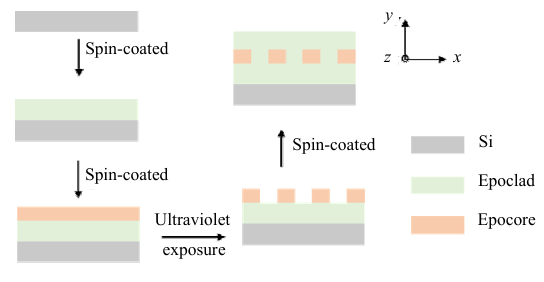
Fig. 4 Fabrication process.